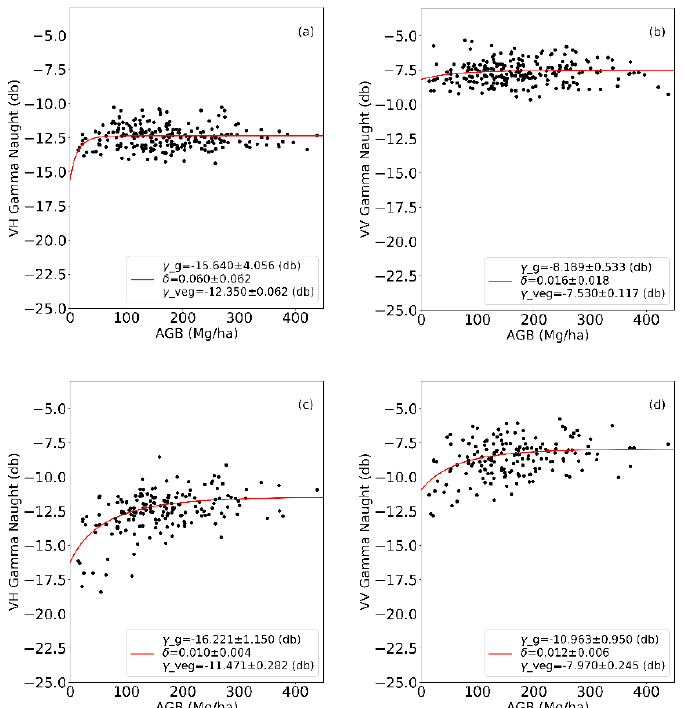
Figure 3. Relationship between the backscattering amplitudes and AGB using the SWCM. ( a ) S1VH: scattering amplitude from pure forest canopy is −12.35 dB, from bare soil is −15.64, and the extinction coefficient is 0.06. ( b ) S1 VV: scattering amplitude from pure forest canopy is −7.53 dB, from bare soil is −8.19, and the extinction coefficient is 0.016. ( c ) P2 VH: scattering amplitude from pure forest canopy is −11.47 dB, from bare soil is −16.22, and the extinction coefficient is 0.01. ( d ) P2 VV: scattering amplitude from pure forest canopy is −7.97 dB, from bare soil is −10.93, and the extinction coefficient is 0.012. At VH polarization, C-band has much higher extinction coefficient than the L-band, which saturated much faster.